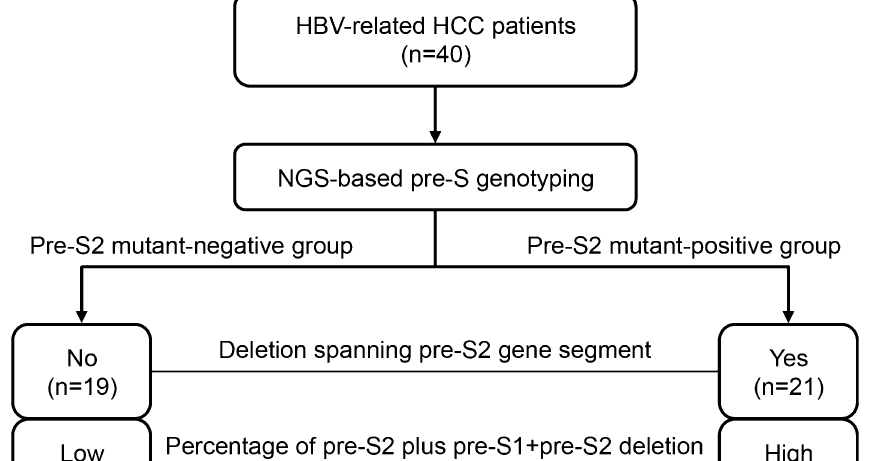
of pre-S2 plus pre-S1 + pre-S2 deletion in patients (Tables 1 and 2). The correlation between the pre-S deletions and other clinicopathological factors was summarized in Supplementary Tables S2 and S3. Pre‑S2 mutant‑positive patients displayed a significantly lower density of granzyme B‑ but higher density of Foxp3‑expressing cells in HCC tissues. Considering that granzyme B and Foxp3 are essential for CTLs- and Tregs-mediated immune responses, respectively 26,28 , their expression in HCC tissues was examined as shown in Supplementary Figures S2 and S3. As shown in Fig. 4A,B, the density (mean ± SEM) of granzyme B- and Foxp3-expressing cells in HCC tissues of the 40 HBV-related HCC patients was 5.53 ± 0.77 and 35.58 ± 4.45 cells/mm 2 , respectively. The density of granzyme B-expressing cells in HCC tissues was signifi- cantly lower in patients with either deletion spanning pre-S2 gene segment or high percentage of pre-S2 plus pre-S1 + pre-S2 deletion than those without (mean ± SEM, 2.55 ± 0.32 versus 8.83 ± 1.19 cells/mm 2 , P < 0.0001; 2.29 ± 0.36 versus 7.48 ± 1.03 cells/mm 2 , P = 0.0006, respectively) (Fig. 4C,D; left graphs). Conversely, the density of Foxp3-expressing cells in HCC tissues was significantly higher in patients with either deletion spanning pre- S2 gene segment or high percentage of pre-S2 plus pre-S1 + pre-S2 deletion than those without (mean ± SEM, 55.23 ± 5.55 versus 13.87 ± 1.56 cells/mm 2 , P < 0.0001; 63.63 ± 6.59 versus 18.76 ± 2.19 cells/mm 2 , P < 0.0001, respectively) (Fig. 4C,D; right graphs). The same correlation was observed when the density of granzyme B- and Foxp3-expressing cells in HCC tis- sues was divided into the high and low density based on the mean density. As shown in Tables 1 and 2, patients with either deletion spanning pre-S2 gene segment or high percentage of pre-S2 plus pre-S1 + pre-S2 deletion were significantly associated with low density of granzyme B- and high density of Foxp3-expressing cells in HCC tissues ( P < 0.0001).